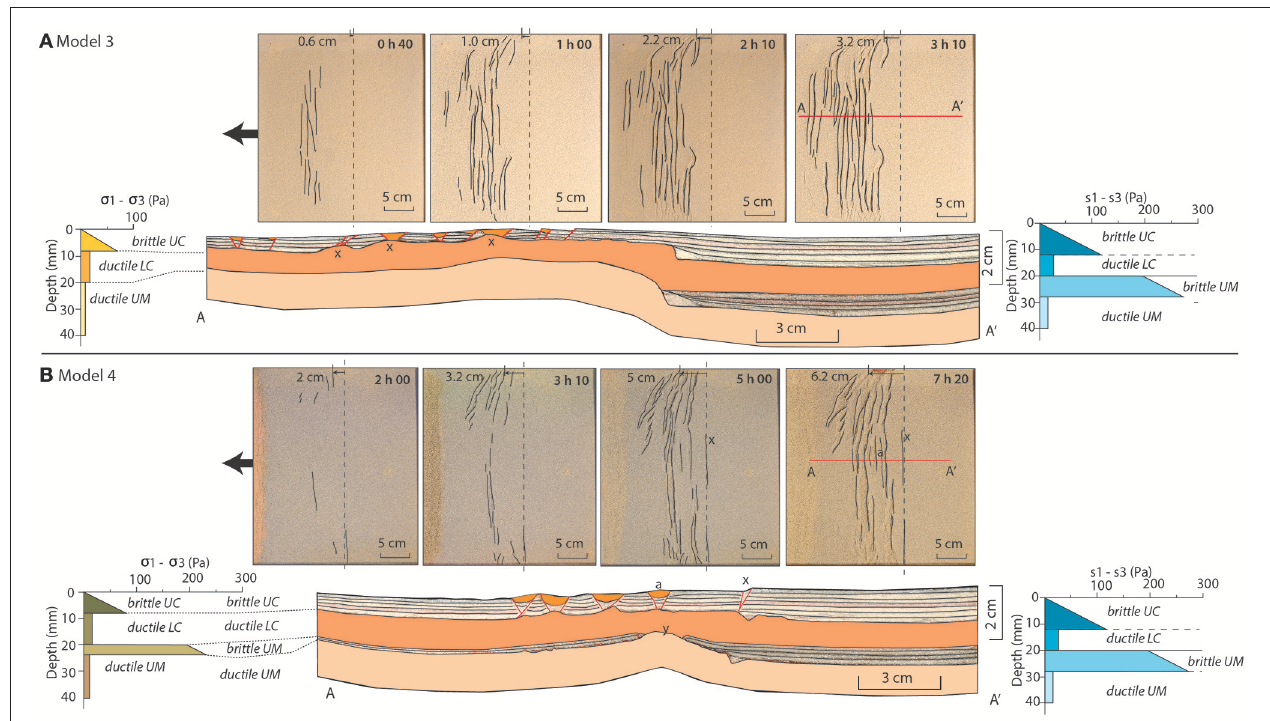
FIGURE 4 | Experimental results of homogeneous lithospheric setup (A) Model 3 (M3) and (B) Model 4 (M4). M3 and M4 show that all extension is accommodated in the weak segment. The thickness of the weak segment of M3 decreases with 35% in a distributed fashion. In the weak segment of M4 the sub-Moho mantle has lost its strength and thickness decreases with 35% at the necking domain ( B , location y). The original thickness of the strong domains of both models remains. The bracketed line on the top-view images represents the contact between the two lithospheric segments. BC, brittle crust; DC, ductile crust; BM, brittle mantle; DM, ductile mantle